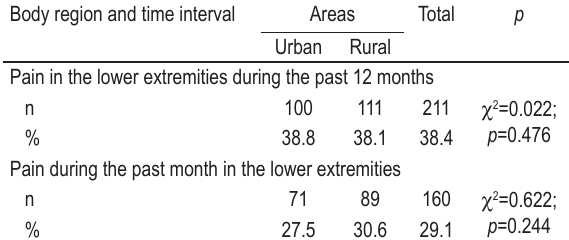
TABLE 7. The presence of pain in lower extremities Body region and time interval Areas Total